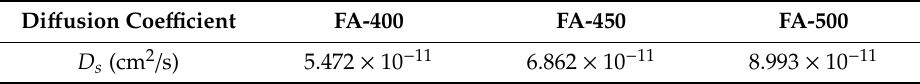
Table 3. Calculated di ff usion coe ffi cients of oxygen in the substrate obtained by Equation (30). Di ff usion Coe ffi